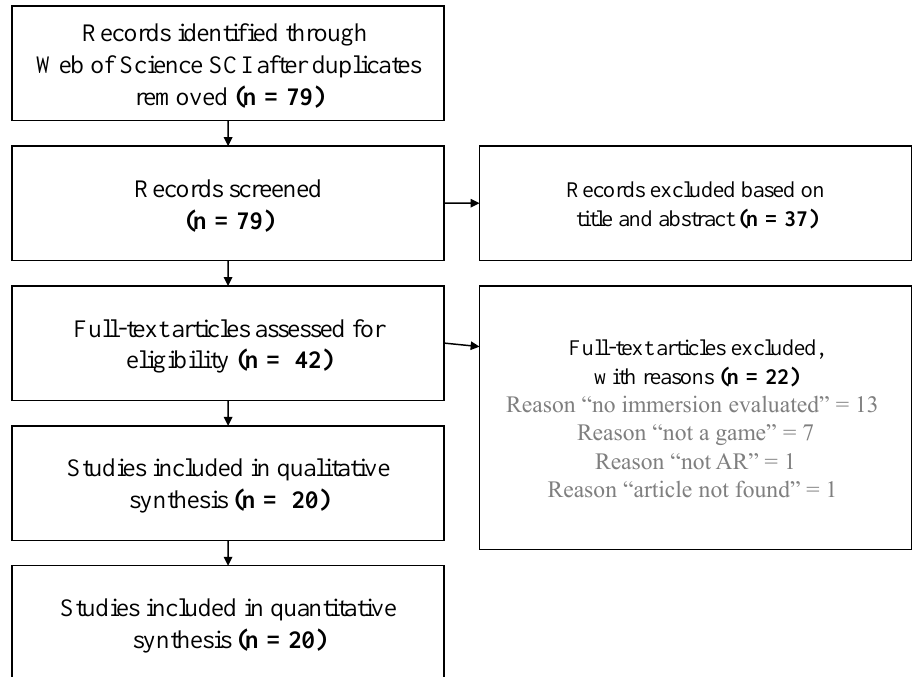
Figure 1. Summary of the identification, screening, eligibility, and inclusion of studies according to including and exclusion